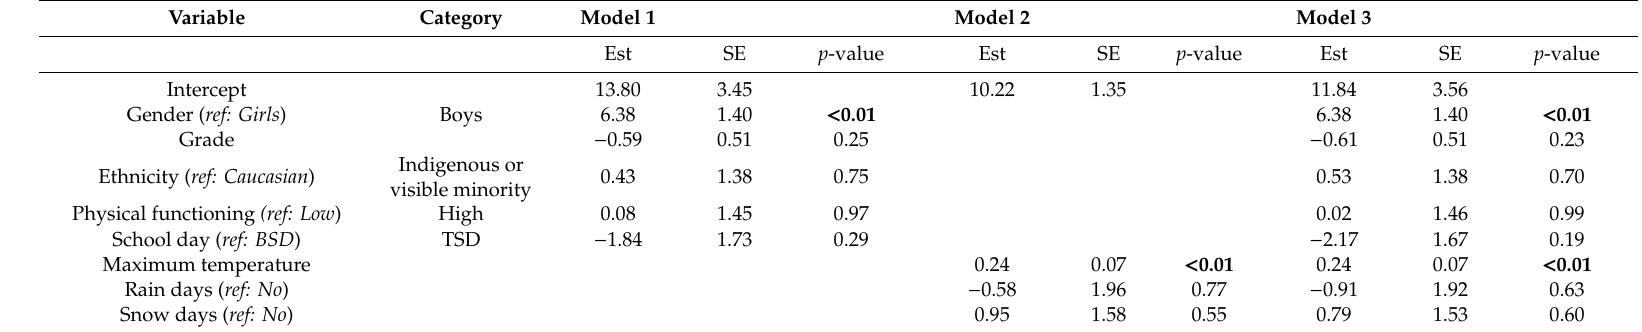
Table 2. The mixed model assessing the relationship between children’s recess MVPA and child variables (Model 1), day variables (Model 2), and child- and day-level variables (Model 3).